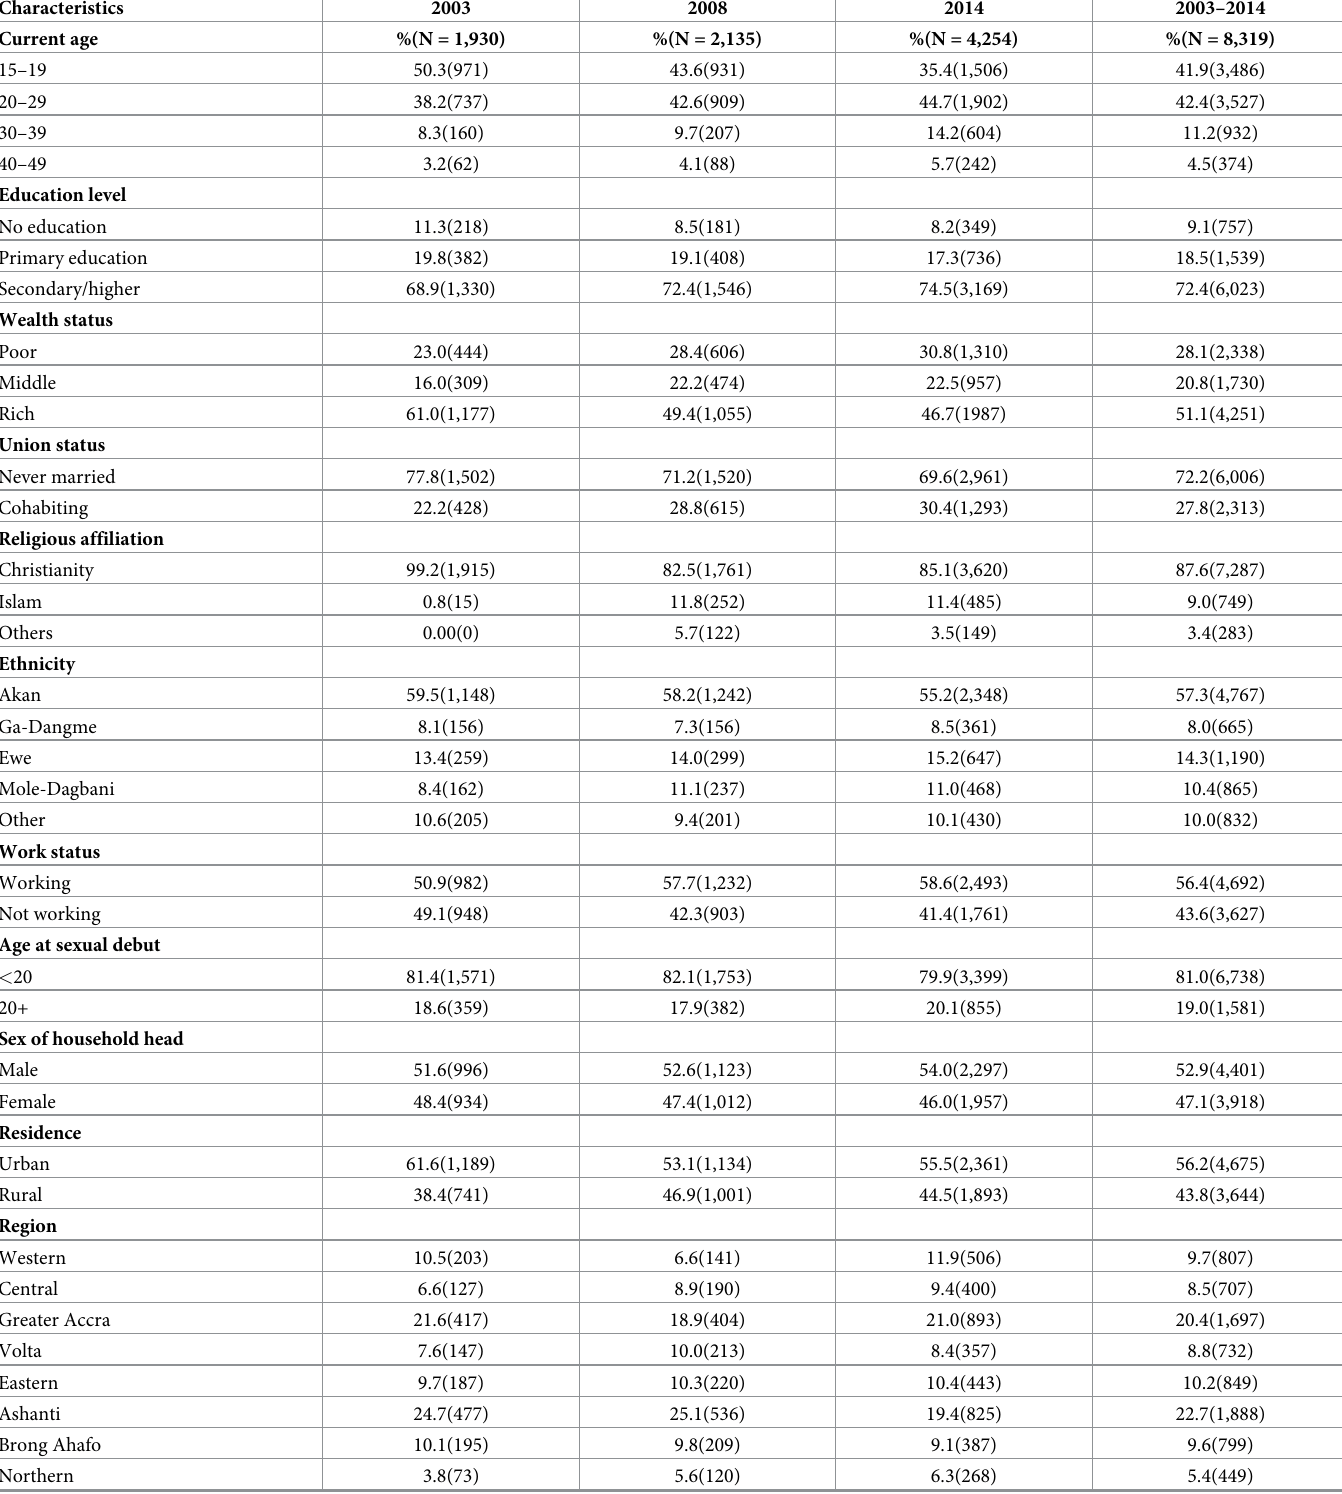
Table 1. Background characteristics of the